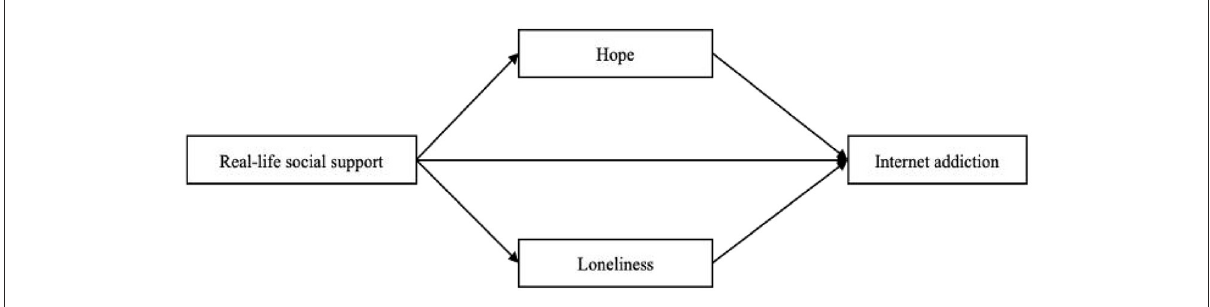
FIGURE1 The conceptual model of this